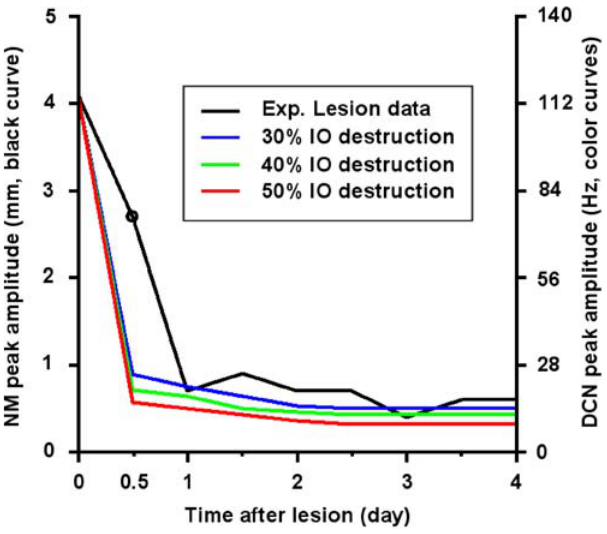
Figure 12. Simulation of IO lesion in classical eyeblink (nictitating membrane) conditioning. The black curve indicates the experimental data from McCormick et al. (1985) after an IO lesion. The first data point at 0 day is the pre-lesion NM peak amplitude ( , 4.1 mm) after full acquisition of the classical delay conditioning. Also note that the circled point is the first peak amplitude of nictitating membrane (NM) response in mm (ordinate on the left side) 12 hours after IO lesion. The blue, green and red curves indicate the simulation results of the peak DCN firing rate (in Hz, ordinate on the right side) during test trials with IO destruction percentages of 30%, 40% and 50%, respectively. A noticeable difference is seen for the first trial after IO lesion. The differences between the experimental data and the results of the simulation cannot be explained by the degree of IO lesion. See text for more